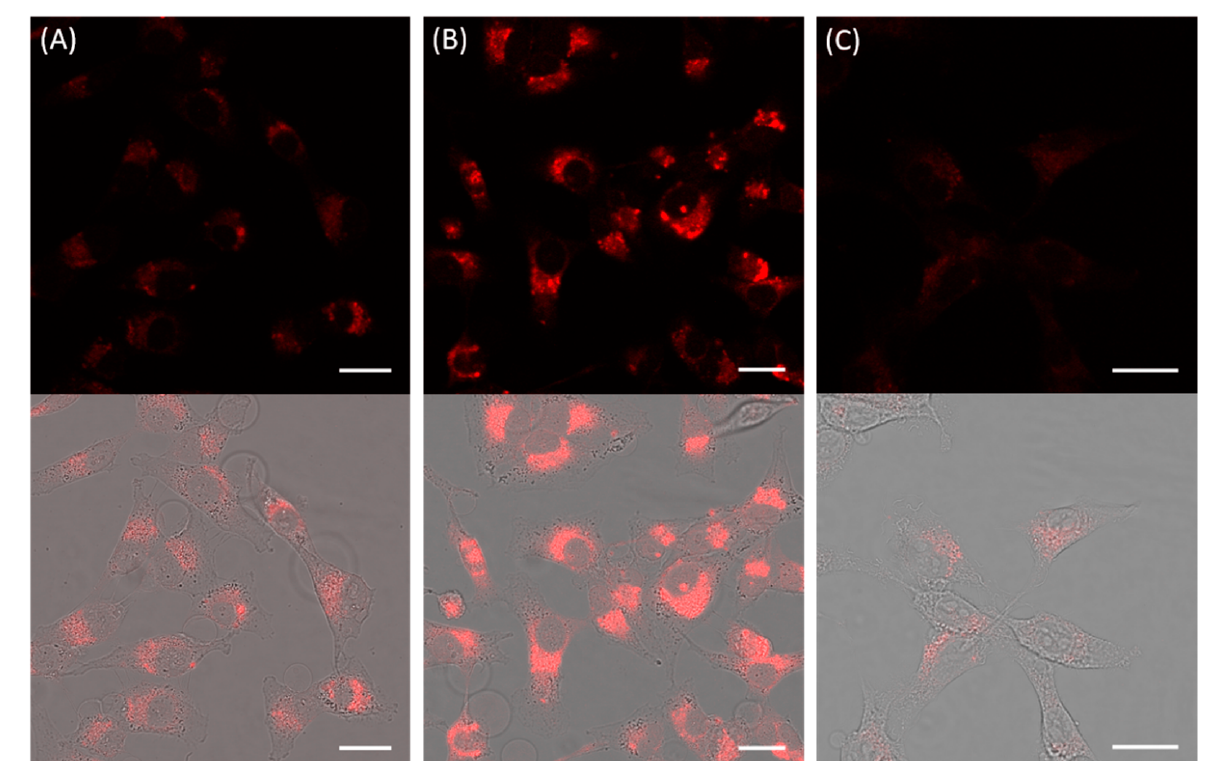
Figure 3. Representative confocal microscopy images of cells incubated with modified and non-modified QD NAs (10 nm, 6 h, 37 ◦ C): ( A ) MDA-MB-231 cells treated with QD NAs; ( B ) MDA-MB-231 cells treated with mAb-QD NAs; and ( C ) MDA-MB-231 cells pre-treated with free anti-CD44 mAb molecules (2 µ g/mL, incubation for 1 h at 37 ◦ C), and treated further with mAb-QD NAs. Fluorescence was collected using a LP 560 emission filter under excitation at 405 nm and using a 63 × objective. In the upper line, the fluorescence channel with the fluorescence of the QD NAs displayed in red is shown, and is merged with the transmission channel as shown in the lower line. The scale bars correspond to 25 µm.